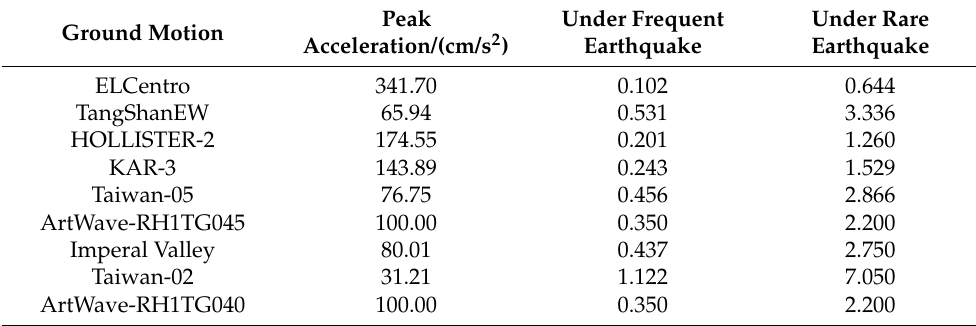
Figure 4. Earthquake acceleration response spectrum for frequent earthquake. Table 2. Amplitude scaling factor.